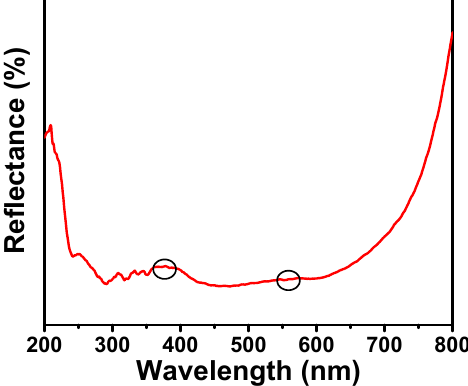
Figure 1. DRS spectra of bio-reduced CuO NPs.